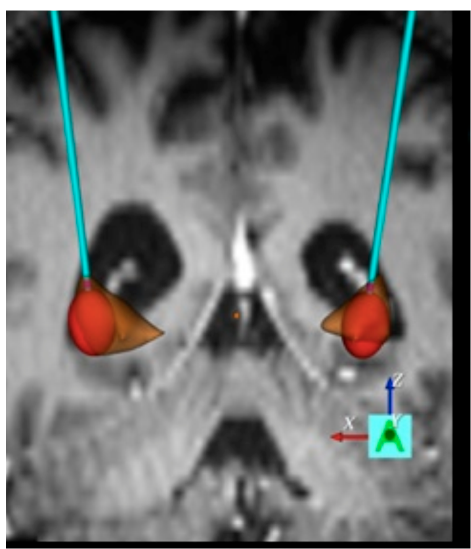
Figure 3. Stimulated target. Example visualization on 3D coronary MRI-view of individual electrodes and volume of tissue activated (VTA, in red) in relation to the pallidum (in brown). Image source: authors’ own contribution.